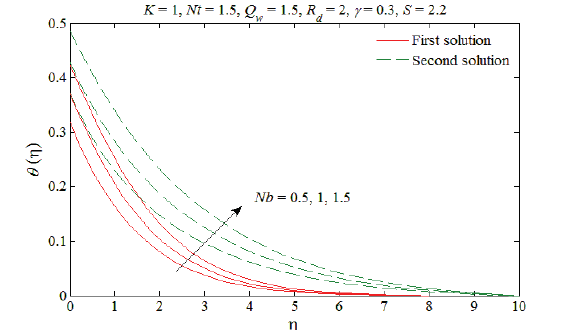
Fig. 4: The temperature profiles for different values of Nb .